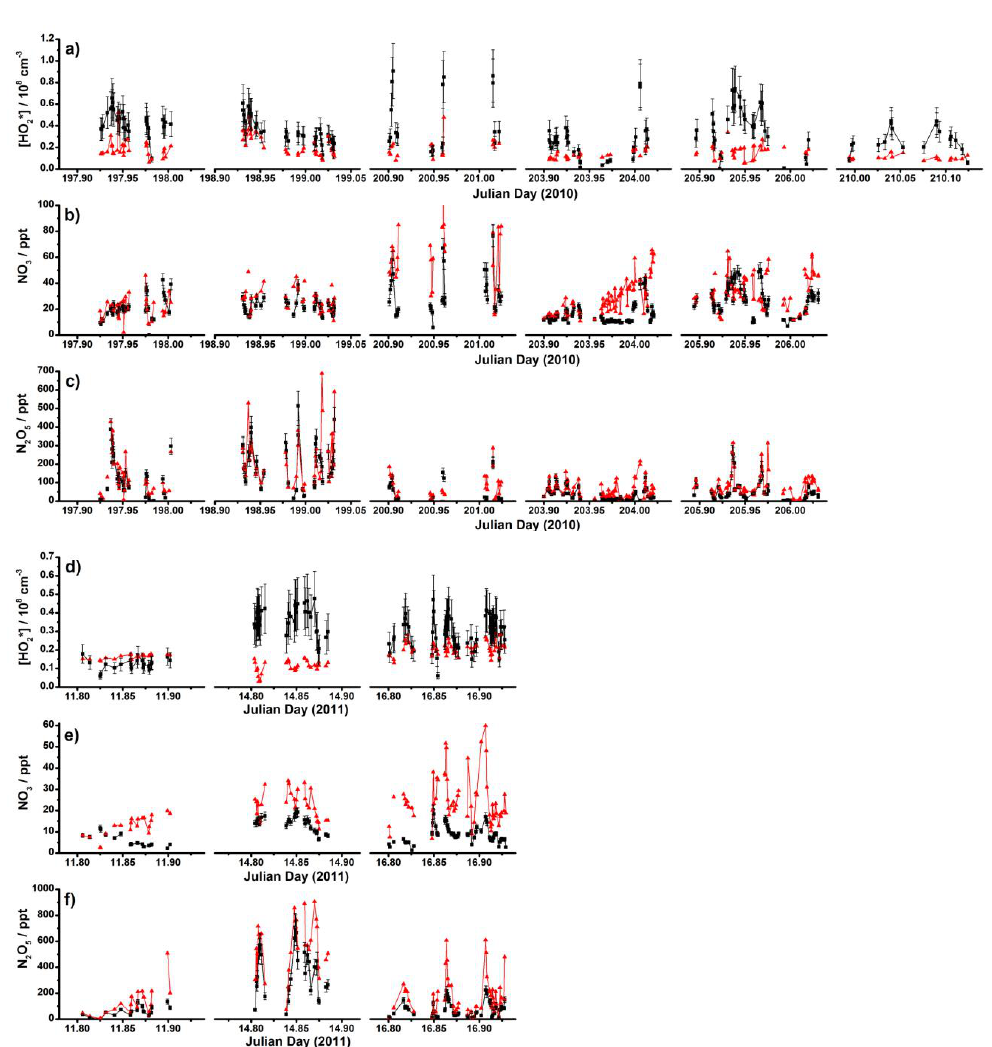
Figure 3: Time series of observed (black) and modelled (red) concentrations of (a) HO 2 * during the summer campaign; (b) NO 3 during the summer campaign; (c) N 2 O 5 during the summer campaign; (d) HO 2 * during the winter campaign; (e) NO 3 during the winter campaign; (f) N 2 O 5 during the winter campaign. Error bars are the 1σ calibration uncertainties. Data for NO 3 and N 2 O 5 above 100 ppt and 1000 ppt, respectively, are not shown for clarity (< 6 data points in total).